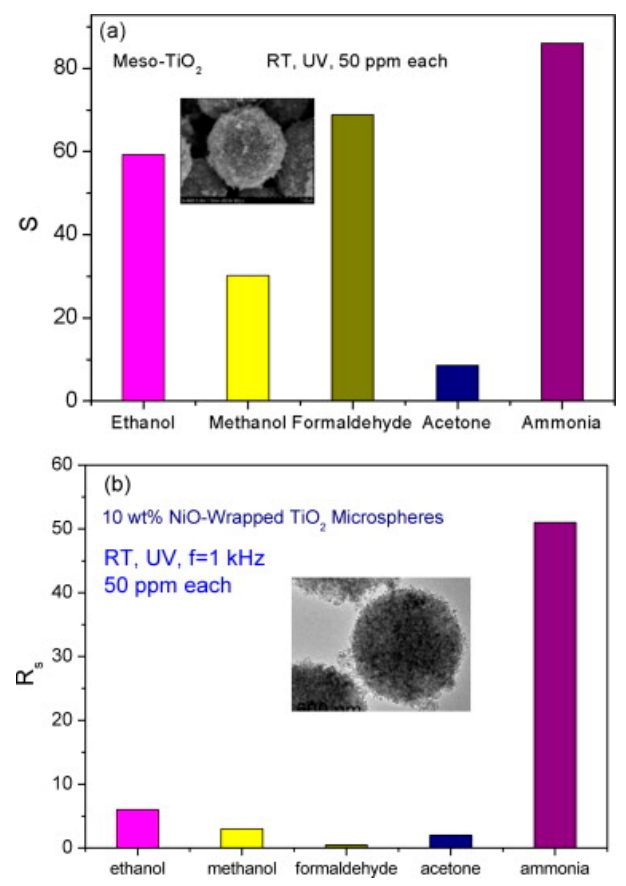
Figure 54. Sensing response of VOCs ( a ) pure meso-TiO 2 and ( b ) 10 wt % NiO-wrapped TiO 2 microspheres based sensors in humid air (RH ~40%) under UV illumination at room temperature. Reproduced with permission from [66].